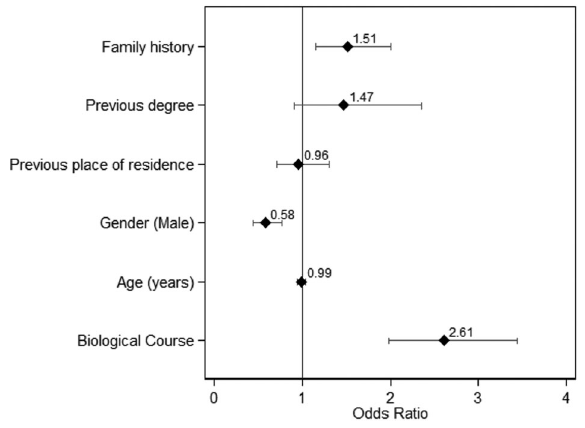
Figure 2. Odds ratios and 95% con fi dence intervals for mentioning cardiac massage among fi rst-year undergraduates